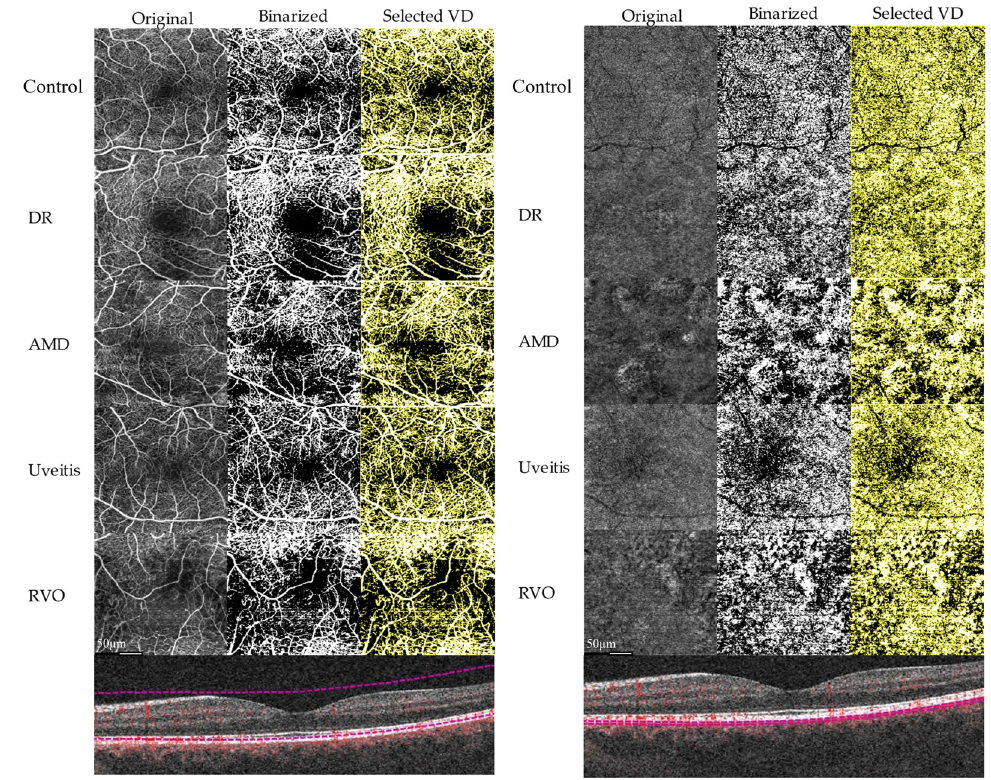
Figure 1. Image processing and vessel density (VD) calculation using the Mean algorithm as an example for the groups control, diabetic retinopathy (DR), age-related macular degeneration (AMD), Uveitis, and retinal vein occlusion (RVO) eyes in full retina angiograms ( left ), and choriocapillaris angiograms ( right ). The respective B-scans below show the segmentation for these layers. All statistical analyses were performed with SPSS Statistics, version 24 (IBM Corpo-